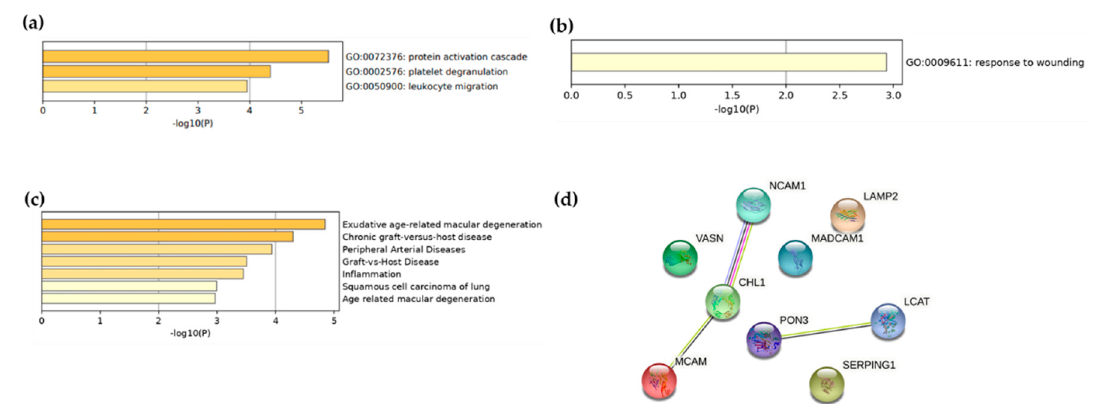
Figure 1. Enrichment analysis of proteins found to be associated with Lp(a) regardless of ( a ) CAVS status and ( b ) in CAVS only. ( c ) DisGeNET enrichment analysis of proteins found to be associated with CAVS Lp(a) and ( d ) interaction analysis between the proteins identified as preferentially associated with the CAVS Lp(a) by STRING-db.